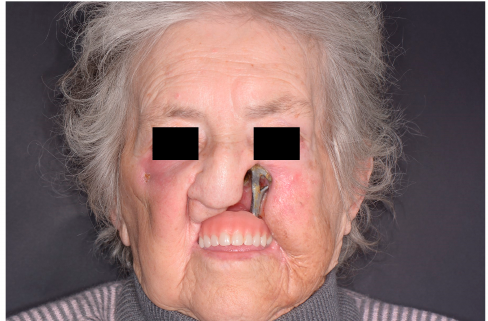
Figure 1. The residual defect after the surgical complication ( fl ap necrosis).